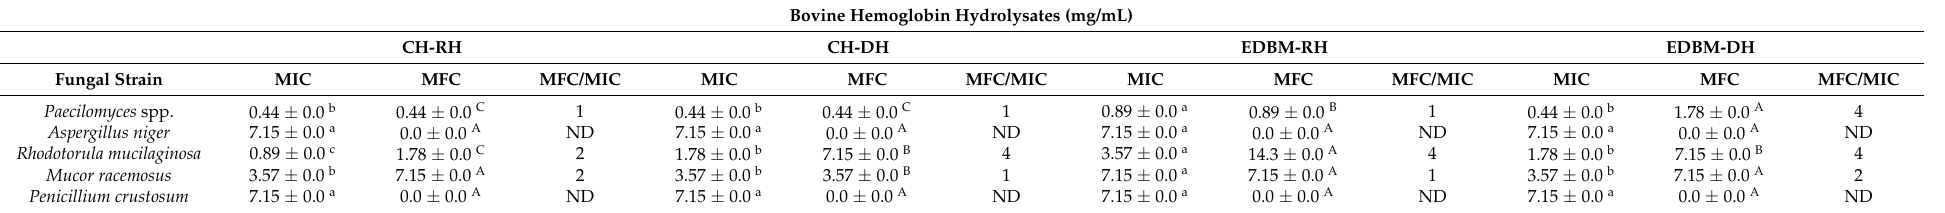
Table 3. In vitro MIC and MFC ranges of CH-RH, CH-DH, EDBM-RH and EDBM-DH against filamentous molds and yeast as determined by broth microdilution followed by visual